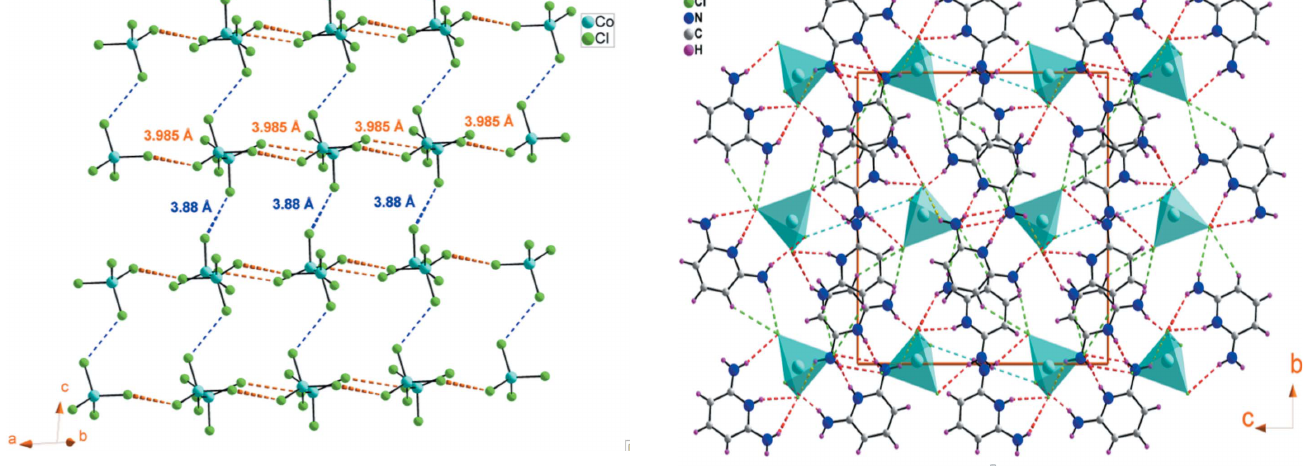
Figure 3 View of (I) towards the bc plane. The dotted lines indicate hydrogen bonds.